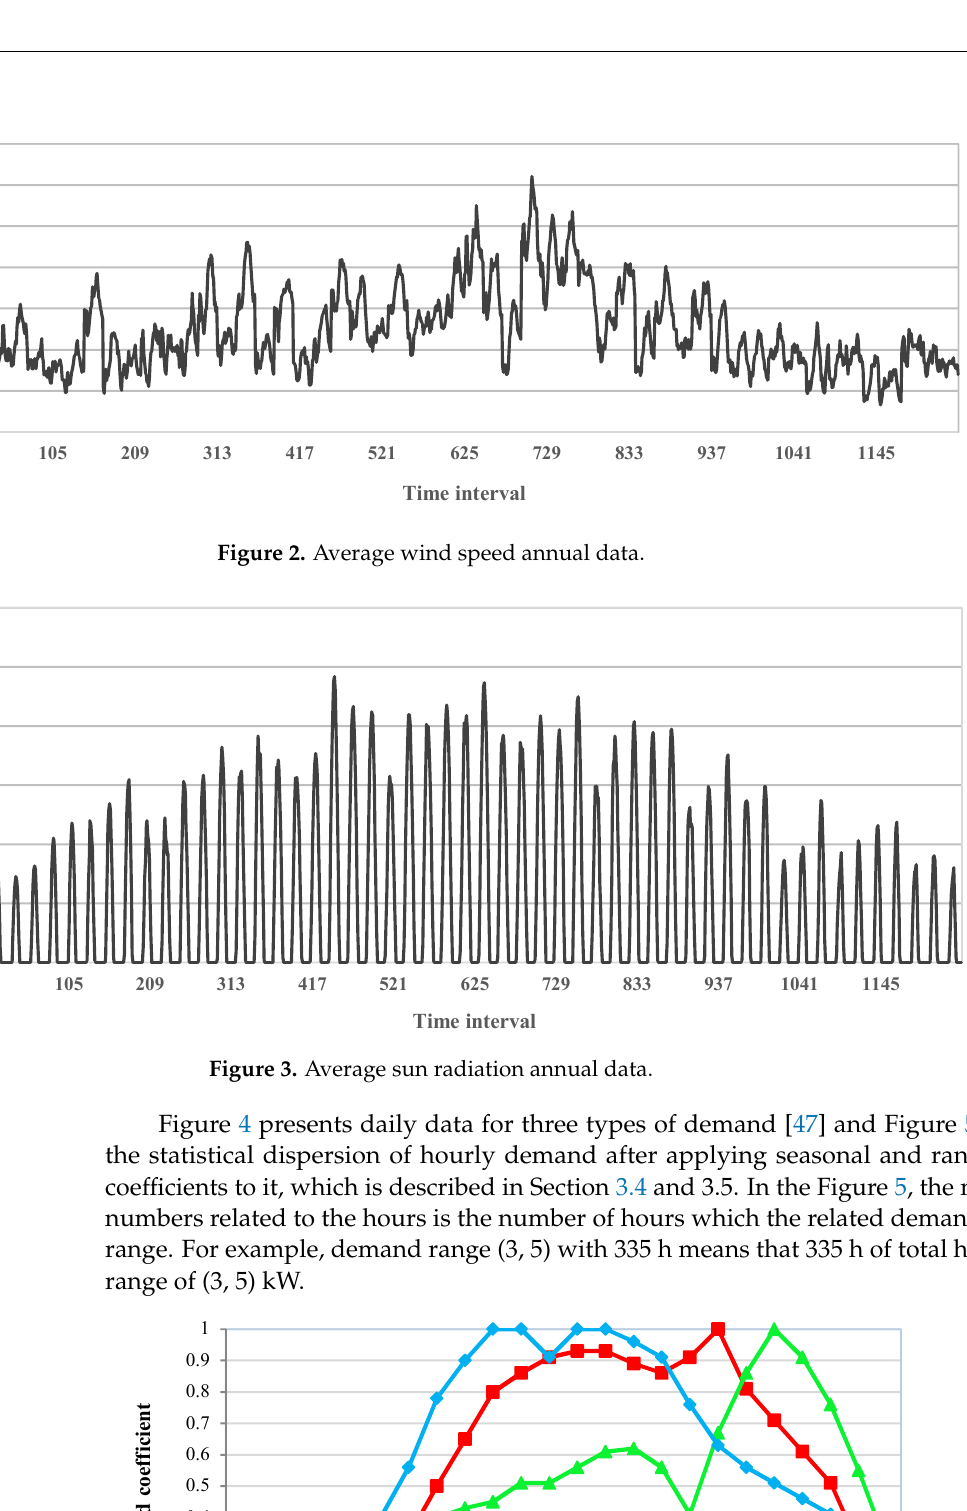
Figure 4. Daily data for three types of demand [47].